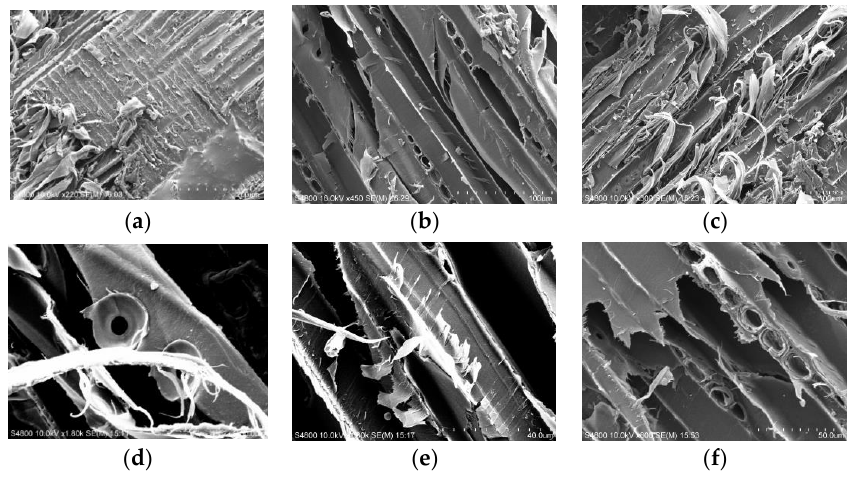
Figure 5. Section morphology under SEM. ( a ) the wood rays are separated from the tracheids altogether; ( b ) earlywood tracheid cracks; ( c ) tearing failure of earlywood tracheid; ( d ) pit in earlywood; ( e ) failure mode of tracheid separation in latewood; ( f ) failure mode of tracheid fracture in late wood.